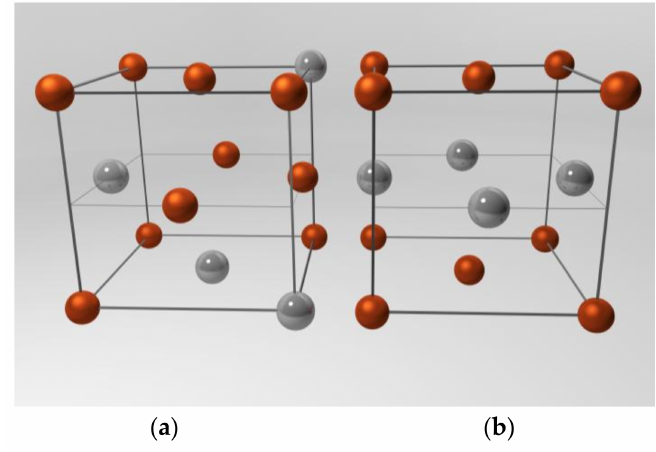
Figure 1. Illustration of ( a ) the unordered face-centered cubic (fcc) structure with randomly assembled iron (brown) and platinum (grey) atoms (arbitrarily chosen assembly) and ( b ) the ordered face-centered tetragonal (fct) phase with alternating layers of iron and platinum atoms (ordered L1 0